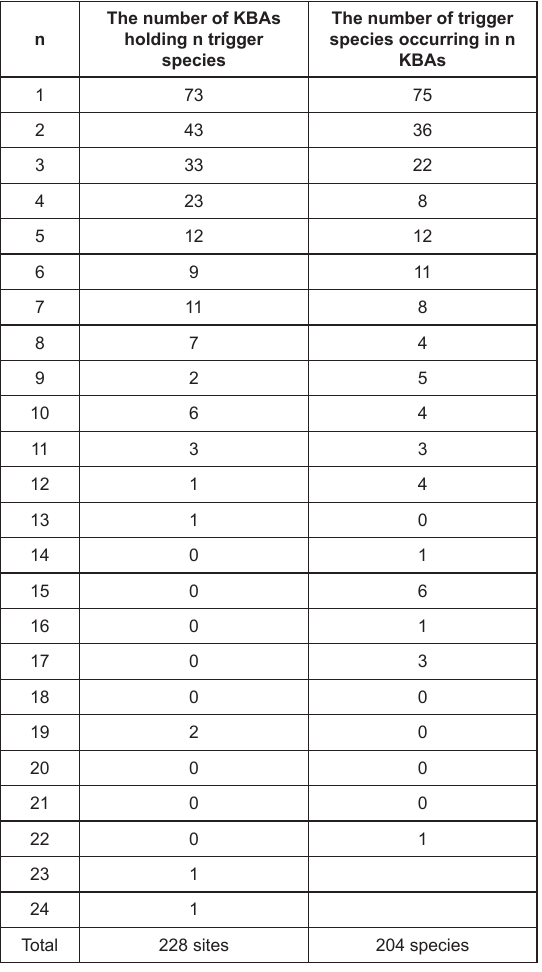
Table 6. Frequency distributions of the number of trigger species per KBA, and the number of KBAs per trigger